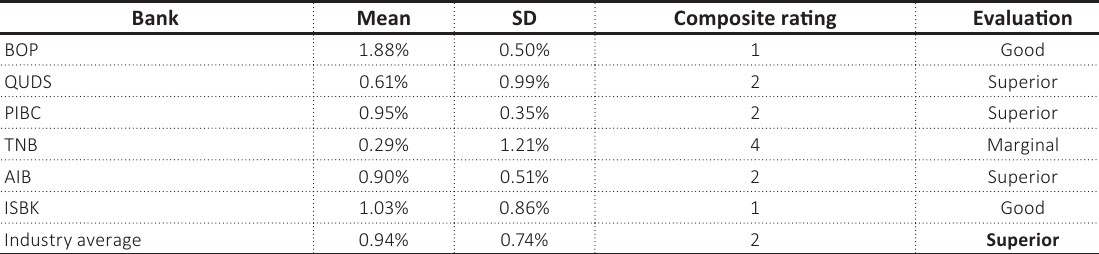
Table 8. Average return on assets